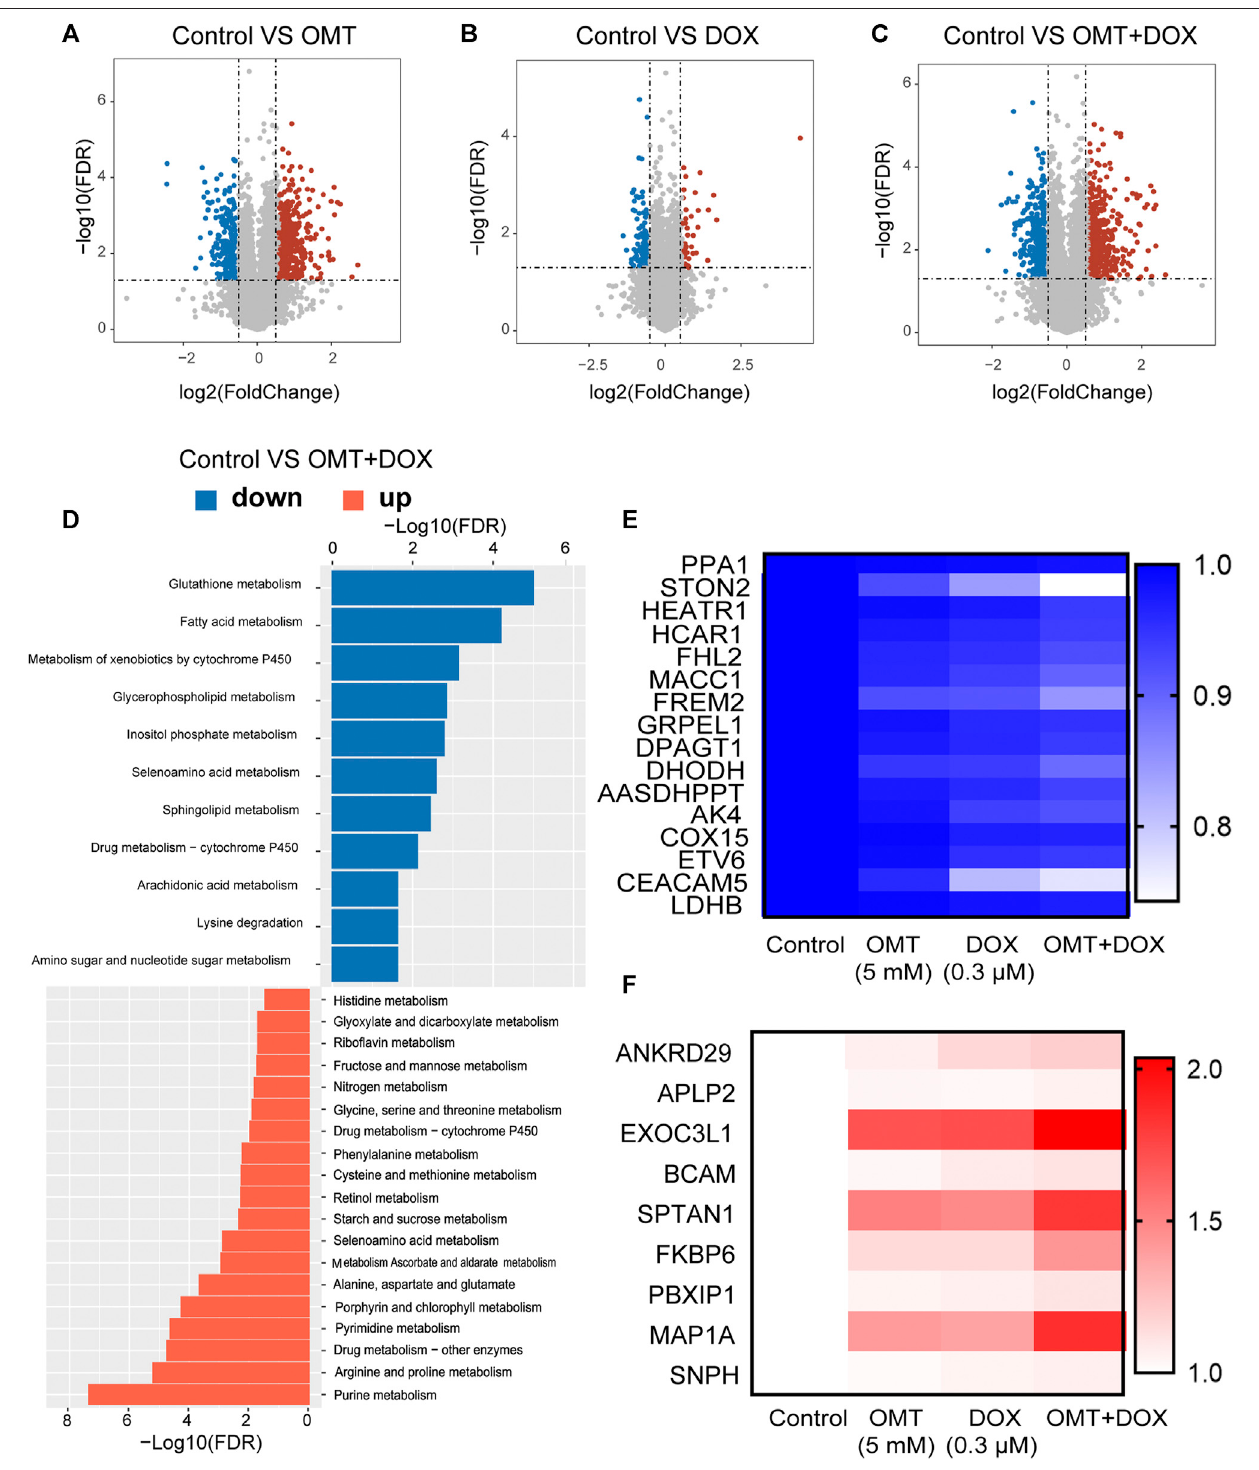
FIGURE 7 | RNA-seq analysis of mRNA expression of OMT and DOX in HT-29 cells. (A – C) Volcano map showing changes in mRNA levels after OMT and/or DOX treatment. (D) Gene ontology (GO) analysis was utilized to evaluate the canonical pathways in the combination treatment group. (E,F) Heatmap analysis of upregulated or downregulated genes after OMT and/or DOX treatment.